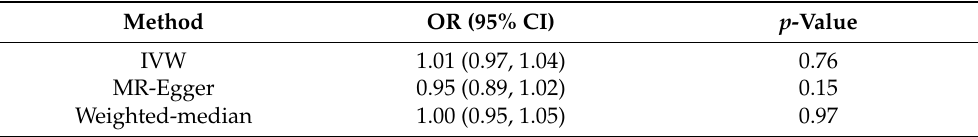
Table 3. Association of genetically predicted AF with